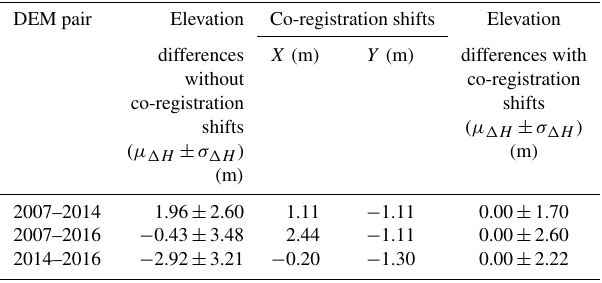
Table 1. Statistics of the elevation differences between DEM pairs before and after the application of co-registration shifts. DEM 2007 is from aerial multispectral survey; DEM 2014 and DEM 2016 are from UAV